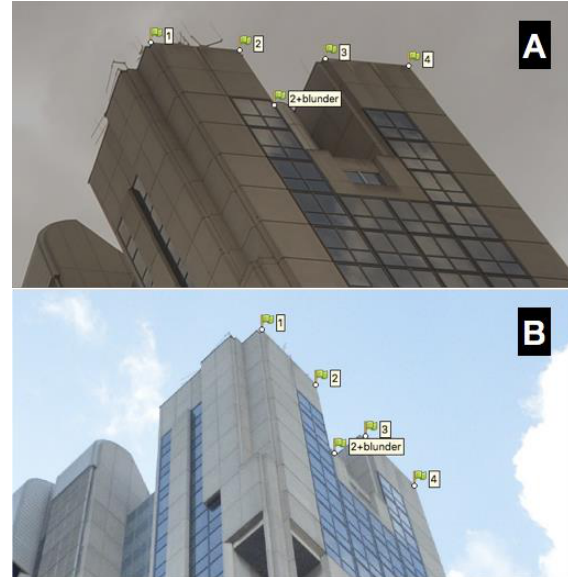
Figure 6. Blunder on point 2